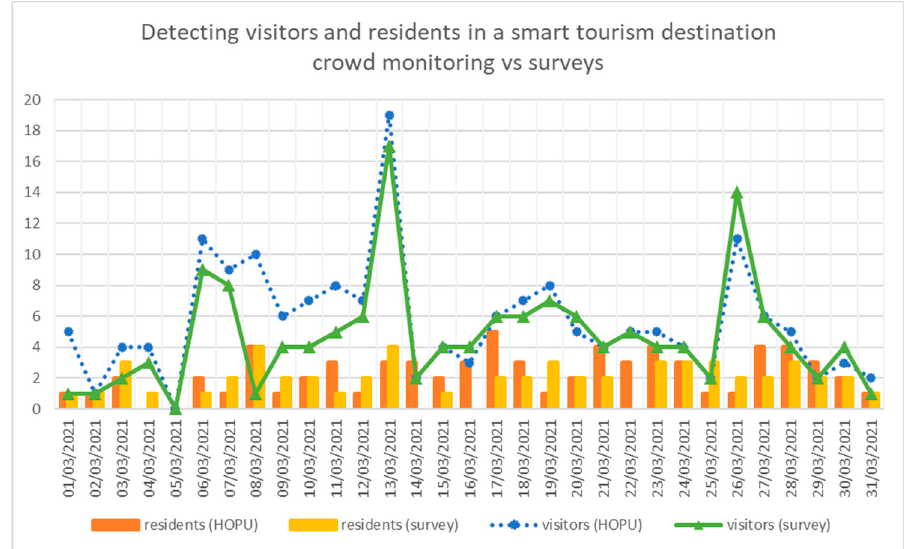
Figure 9. Comparing crowd monitoring visitors and residents in Alcoi by using HOPU Smart Spot vs. manually conducted surveys.